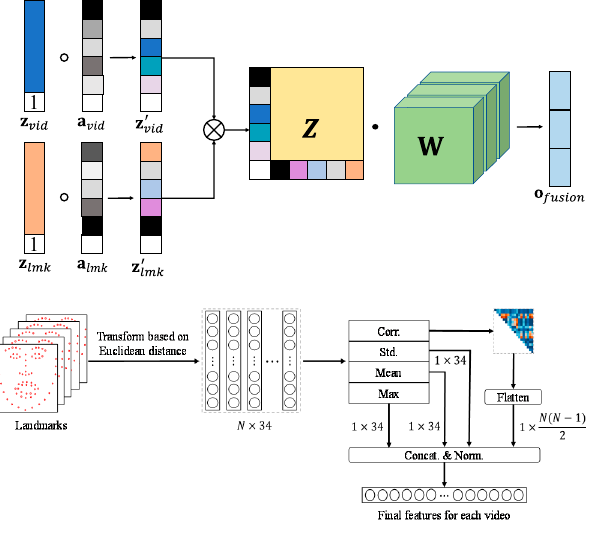
Figure 8. The operation of low-rank multi-modal attention fusion (LRMAF).